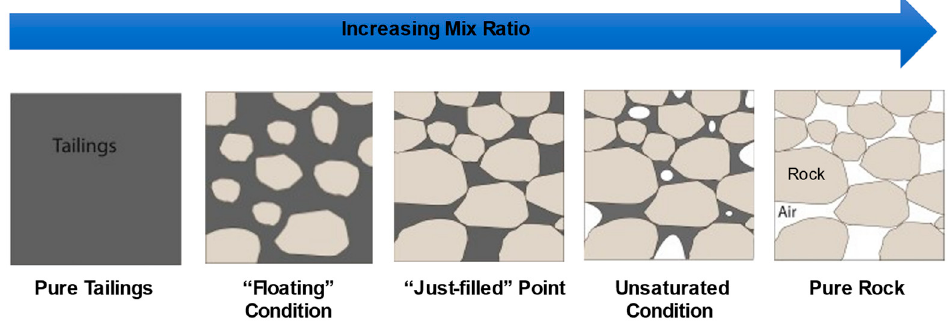
Figure 3. Blend configurations after Wickland et al. (2006) [7].